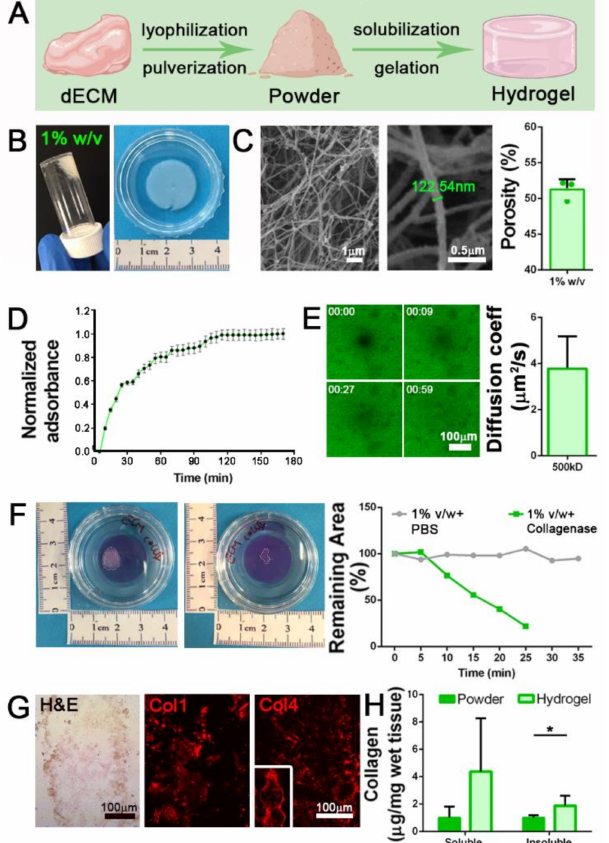
Figure 2. Diaphragmatic dECM-derived hydrogels production. ( A ) Graphical representation of the three-steps protocol to produce diaphragmatic dECM-derived hydrogels. ( B ) Gross appearance of 1% w/v jellified hydrogel. ( C ) SEM analysis of 1% w/v dECM-derived hydrogel and porosity calculation. ( D ) Turbidimetric gelation kinetics of 1% w/v dECM-derived hydrogel, reported in terms of normalized absorbance ( ± s.e.m.) vs. time. ( E ) Fluorescence recovery after photobleaching (FRAP) analysis of 1% w/v hydrogels. Diffusion coefficient for fluorescein isothiocyanate (FITC)- dextran of 500 kDa was calculated by fitting the FRAP data with the Uniform Disk Model (UDM). ( F ) Degradation assay of 1% w/v hydrogels using collagenase II. PBS: 1% w/v hydrogels incubated with PBS (no collagenase II). ( G ) Characterization of 1% w/v hydrogel with hematoxylin and eosin (H&E) stain, and immunofluorescence for collagen 1 (Col1) and collagen 4 (Col4). ( H ) Quantification of soluble and insoluble collagen before (powder) and after hydrogel production. *: p <